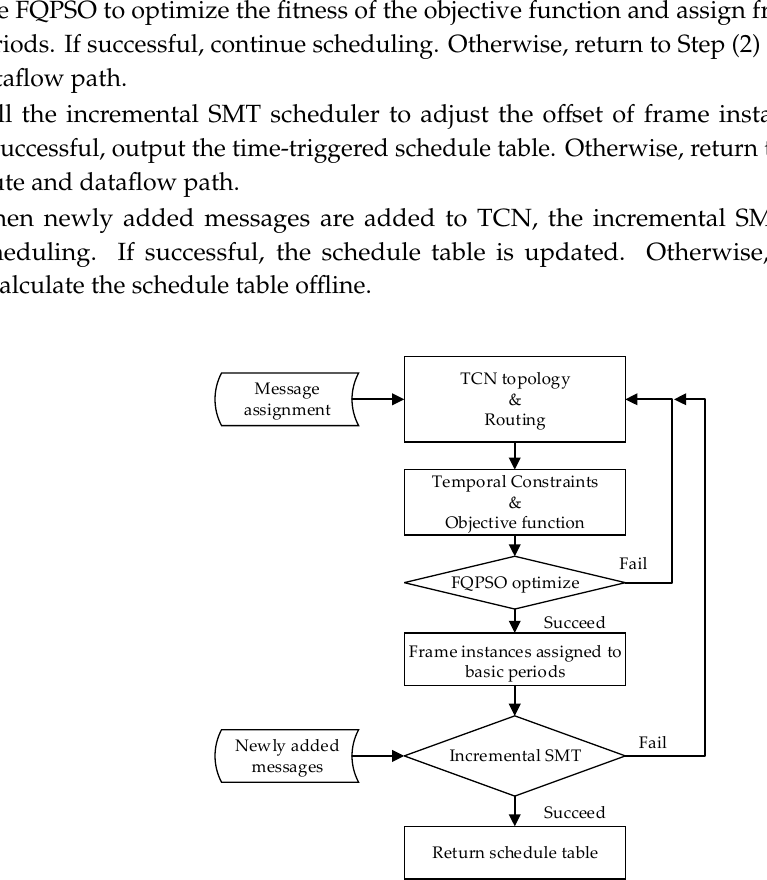
Figure 6. Ethernet train communication network topology. 6.1.2. Message Assignments Message assignment is done by generating dataflow paths each consisting of one sender and one or a set of receivers. In our testbench, a sender is randomly selected from all the EDs, and every message of the sender belongs either to a multicast group or a unicast group. A sender of multicast is allowed to transmit frames to a subset of a configurable group size of receivers. The unicast group is allowed only one receiver binding to a sender for the message. In this article, four types of time- triggered traffic are defined: (1) unicast within subnet: the source unicasts messages to one sink belong to the same TBN; (2) multicast within subnet: the source multicasts messages to 8–10 random sinks under the same TBN; (3) unicast between subset: the source unicasts messages to one sink